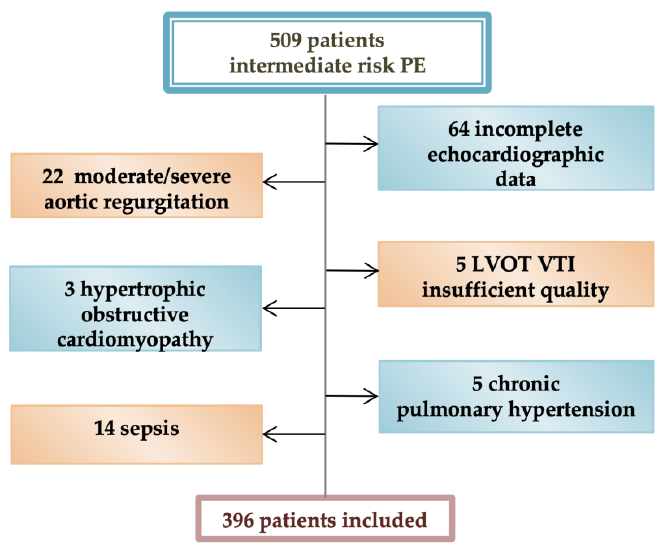
Figure 1 . Study flow diagram . Adverse outcome (including in hospital death, cardiac arrest, development of cardi- ogenic shock or sustained hypotension, need of rescue thrombolysis) was present in 50 patients (12.62%). PE related death was registered in 17 patients (4.3%) and resuscitated cardiac arrest occurred in 6 patients (1.51%). Another 20 patients (5.05%) required escala- tion of therapy with thrombolysis and 7 (1.76%) patients developed hemodynamic insta- bility and received intravenous inotropes. Echocardiographic parameters including RV/LV ratio and LVOT VTI to predict PE-related adverse events, including mortality, car- diac arrest, hemodynamic instability, need of rescue thrombolysis during hospitalization were directly compared in 396 normotensive patients with acute PE. 3.1. Predictors of in Hospital Adverse Outcomes: Death, Resuscitated Cardiac Arrest, Hemodynamic Instability and Need of Reperfusion Therapy Demographic, clinical characteristics and biomarkers values of patients that devel- oped adverse outcomes during hospitalization compared to those with favorable evolu- tion are recorded in Table 1. Table 1. Comparative baseline demographic, clinical and laboratory parameters in patients with and without in hospital adverse outcomes.